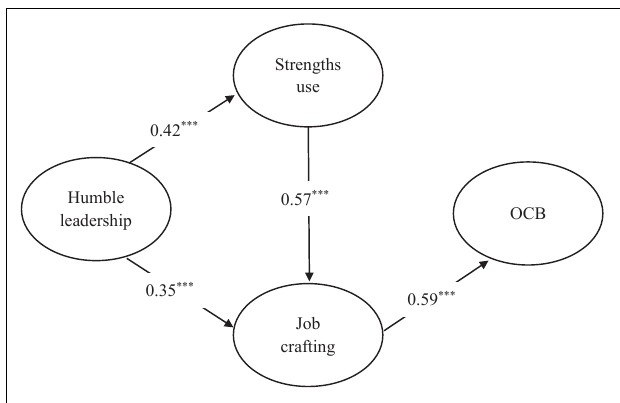
FIGURE 2 | Results of SEM for the modified